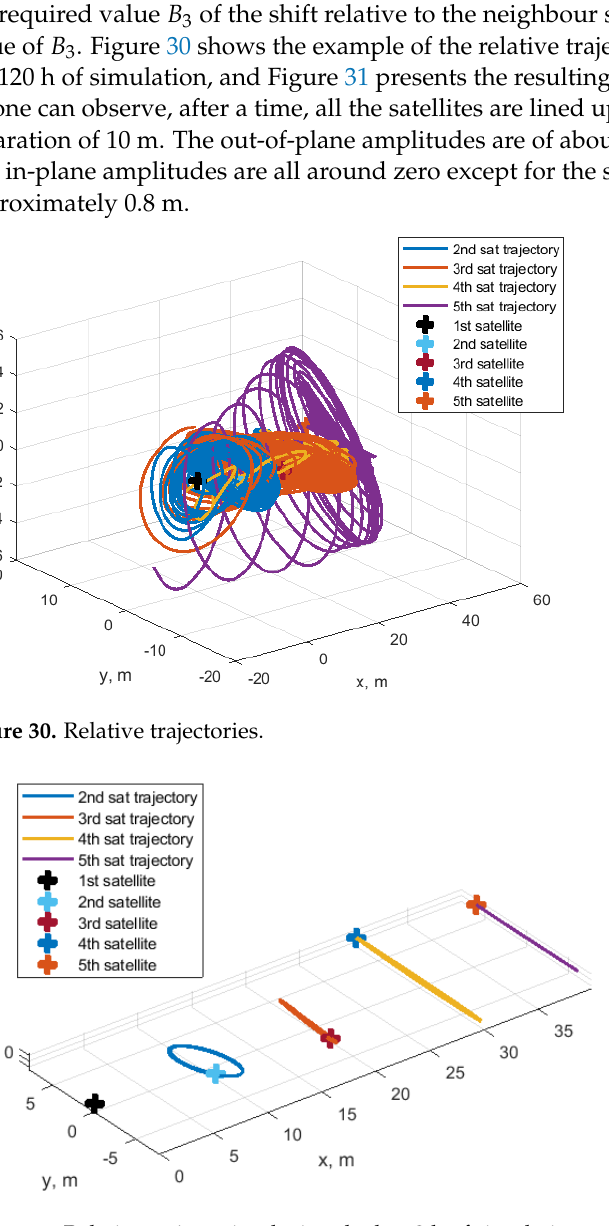
Figure 31. Relative trajectories during the last 2 h of simulation.